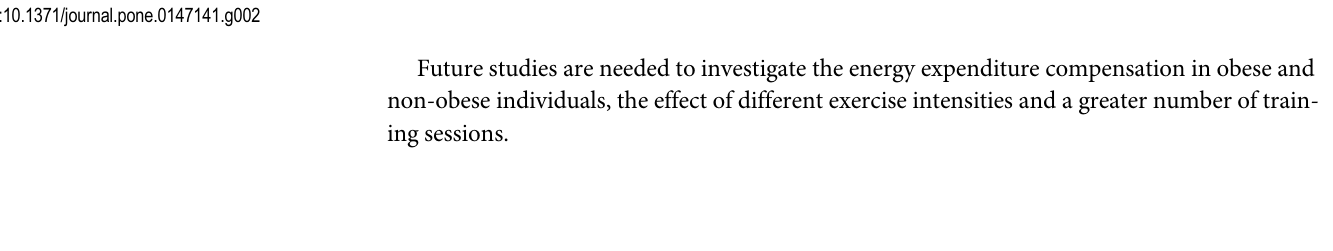
Fig 2. Estimated mean values of the cumulative energy expenditure in 24 hours (A) and 144 hours (B) monitoring. ‡ moderate vs. control; # moderate vs. vigorous; * vigorous vs.